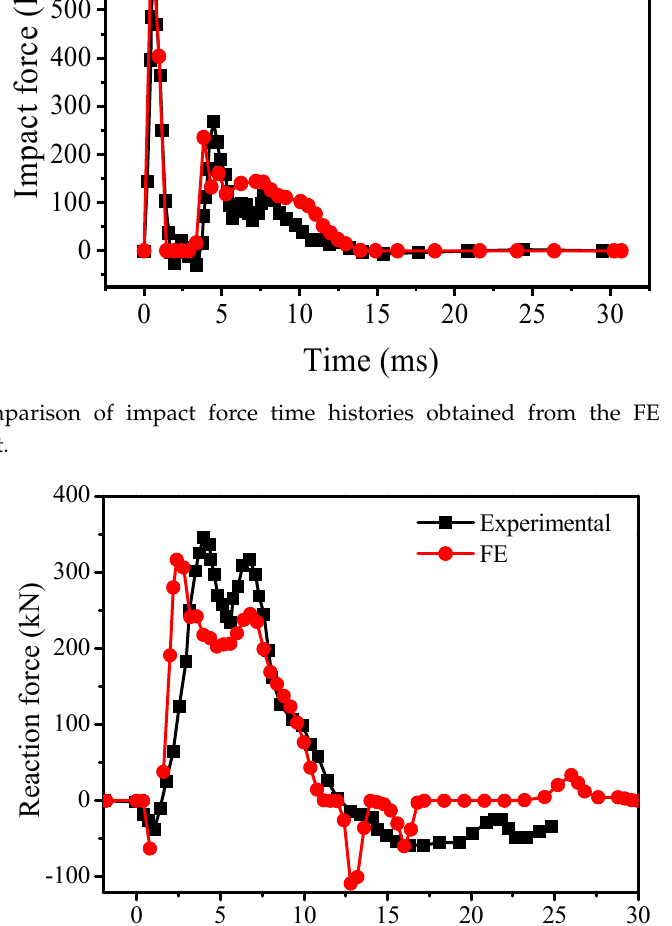
Figure 6. Comparison of mid-span displacement obtained from the FE simulation and the experimental test. 4.3. Fracture Development Process and Failure Mode The comparison of numerical simulation and test results of failure modes for RC T-beam with CFRP under impact load is shown in Figure 7. The failure mode of the CFRP-strengthened beam is mainly subject to oblique cracks caused by shear force, which shows a typical shear failure mode. When the impact force reaches its peak (0.5 ms), two 45° diagonal cracks appear symmetrically on the beam web. At the end of the pulse phase (1.2 ms), the main oblique crack develops downward to the horizontal height of longitudinal reinforcement. When the impact force reaches its second peak